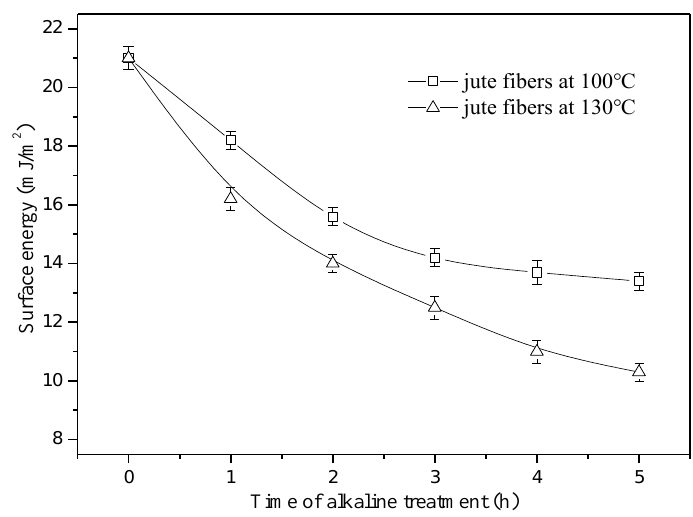
Figure 10. Surface energy of jute fibers pretreated at 100 and 130 °C.